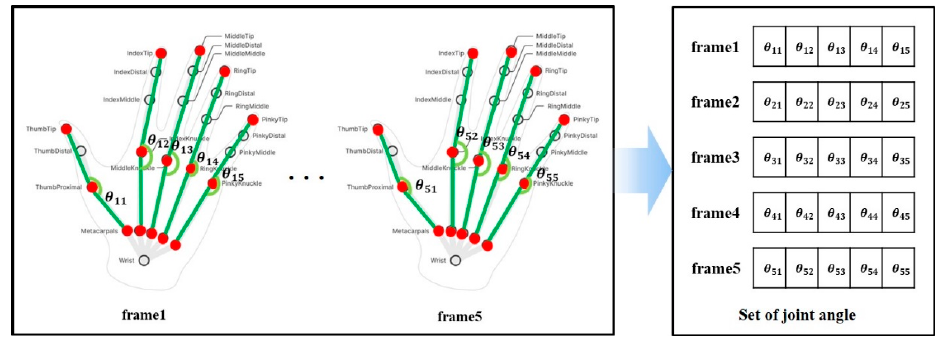
Figure 6. Example of deriving consecutive joint angles.